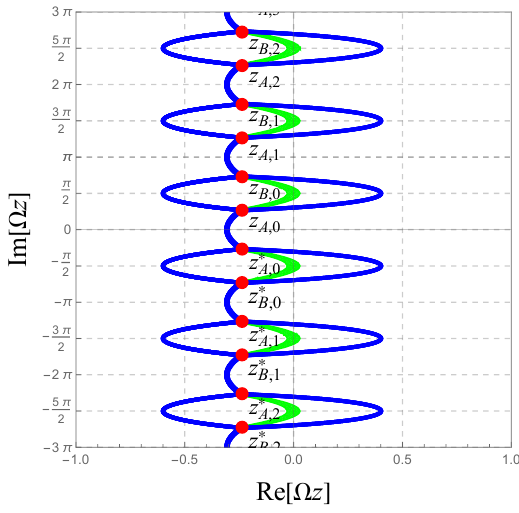
Figure 7 . (color online) A Stokes graph for the Sauter electric field (3.48). The red points, the blue lines, and the green lines are the turning points (D.8), Stokes lines, and branch cuts, respectively. Parameters are taken as m ⊥ / Ω = 1 , eE 0 / Ω 2 = 1 , p / Ω = 0 . 5 k